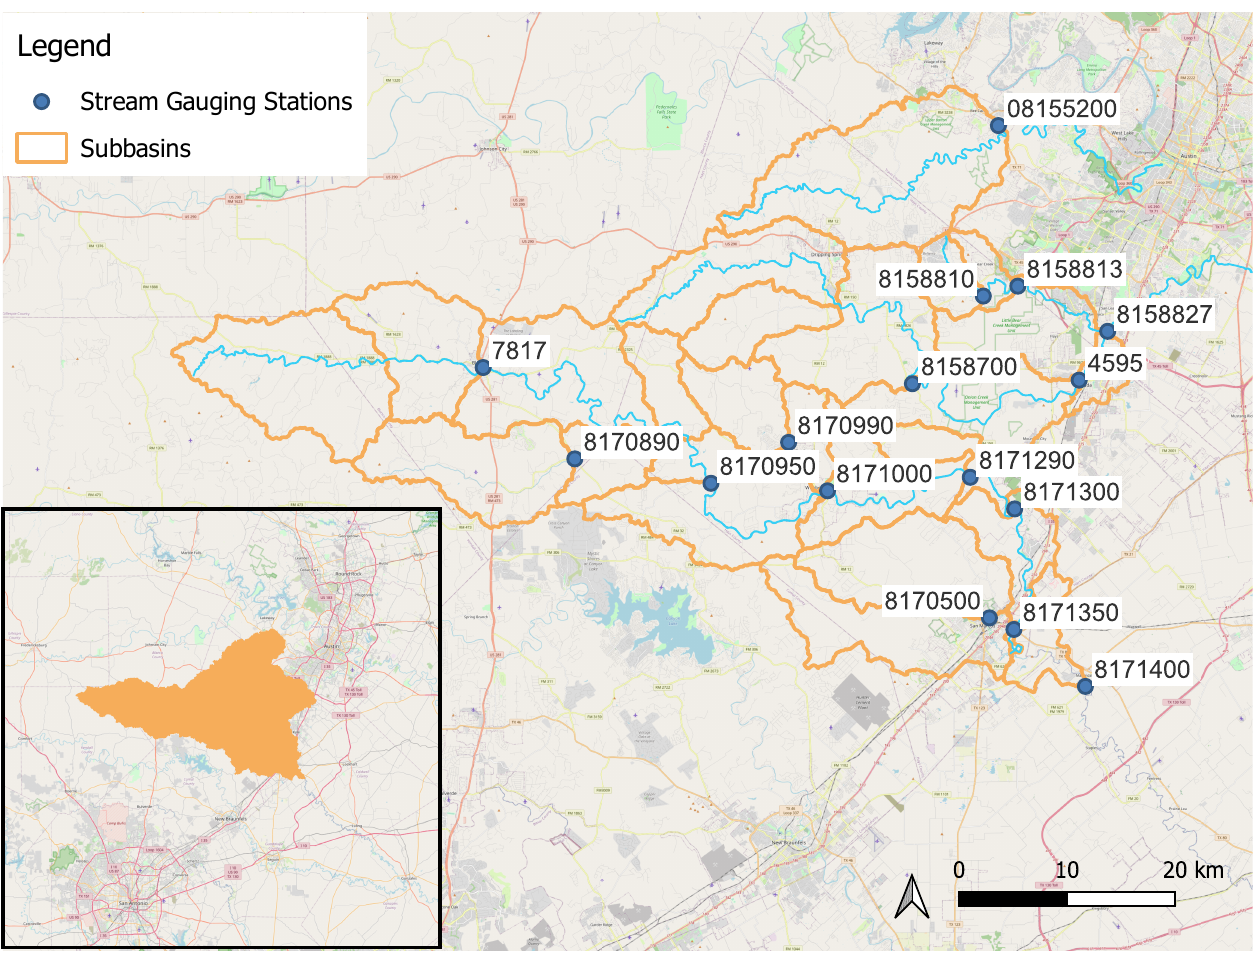
Figure 2. Study site location, stream gauging station configuration, and sub-basins. The study site is between San Antonio and Austin in south-central Texas (TX). 16 stream gauging stations are shown on the Blanco River, San Marcos River, Onion Creek, Bear Creek, and Barton